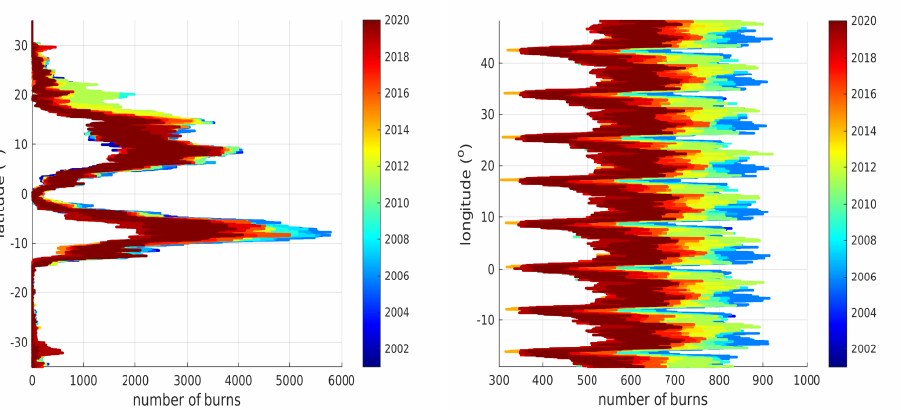
Figure 4. Graphs of fire trends from 2001 to 2020 for the entirety of sub-Saharan Africa. Positive latitude values are northward while positive longitude values are eastward. The value of 0 ◦ latitude corresponds to the equator, and the value of 0 ◦ longitude corresponds to the prime meridian